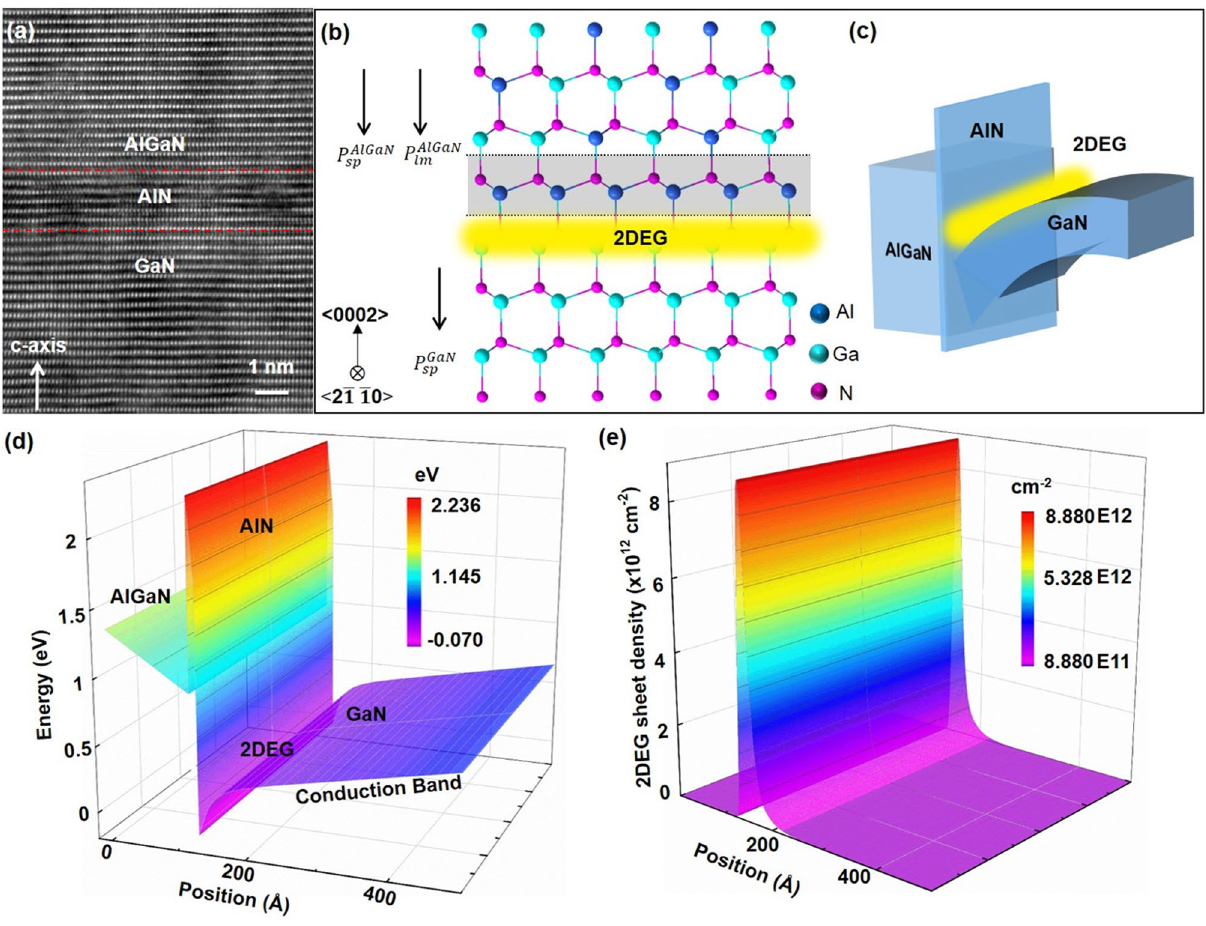
Fig. 2 Atomic characterization of AlGaN/AlN/GaN heterostructure membrane. a The STEM image of heterostructure membrane. The scale bar is 3 nm. b Corresponding atomic structure along the c-axis. c The diagram of conduction band profile and 2DEG. d The calculated conduction band and valence band. e The calculated 2DEG sheet density in AlGaN/AlN/GaN heterostructure